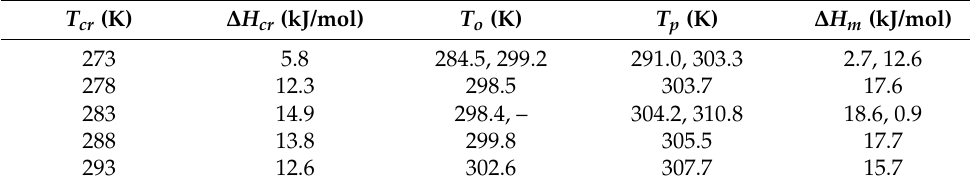
Figure 7. Isothermal cold crystallization of 3F7FPhH6: DSC curves registered during cold crystalliza- tion ( a ) and during subsequent heating with the 10 K/min rate ( b ); absorption part of the BDS spectra during cold crystallization in 268 K ( c ); crystallization degree X ( t ) with fitting results of Equation (6) ( d ); Avramov plot for isothermal cold crystallization in 283 K ( e ); and the Arrhenius plot of the characteristic crystallization time τ cr ( f ). Table 2. Crystallization enthalpy ∆ H cr and melting enthalpy ∆ H m together with onset T o and peak T p temperatures of anomalies related to the melting of a crystal phase after the isothermal cold crystallization of 3F7FPhH6 in various T cr